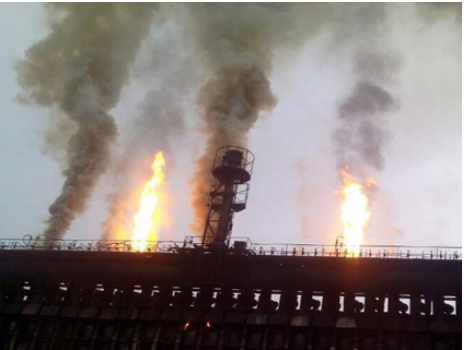
Figure 1. The dust emission during coal charging in the top-charged coke